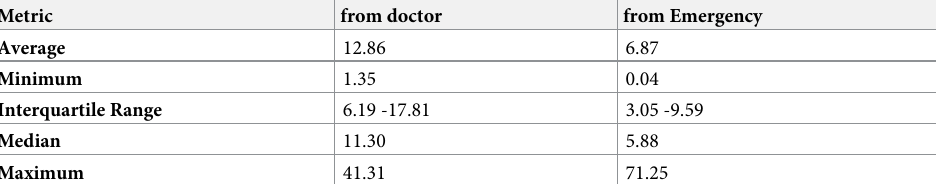
Table 8. The length of the patient journey (in days) into hospital according to the patient refer from type.